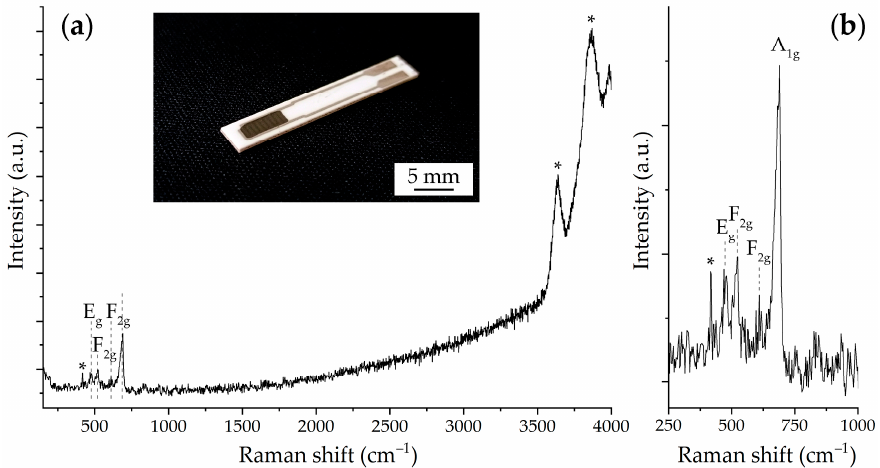
Figure 5. Raman spectra of the developed Co 3 O 4 film: (( a ) overview spectrum, ( b ) spectrum in the 250–1000 cm − 1 range; marker “*” indicates Al 2 O 3 substrate signals), as well as the appearance of the chip with the printed oxide film.